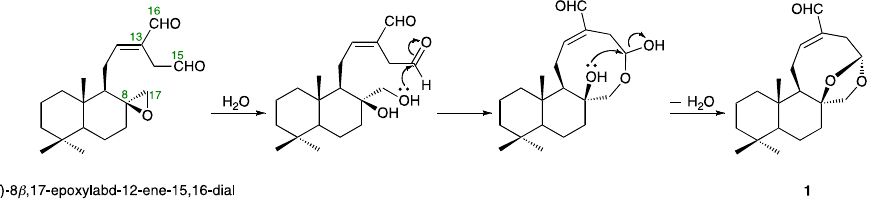
Figure 3. Hypothetical pathway to galangalditerpene A ( 1 ).